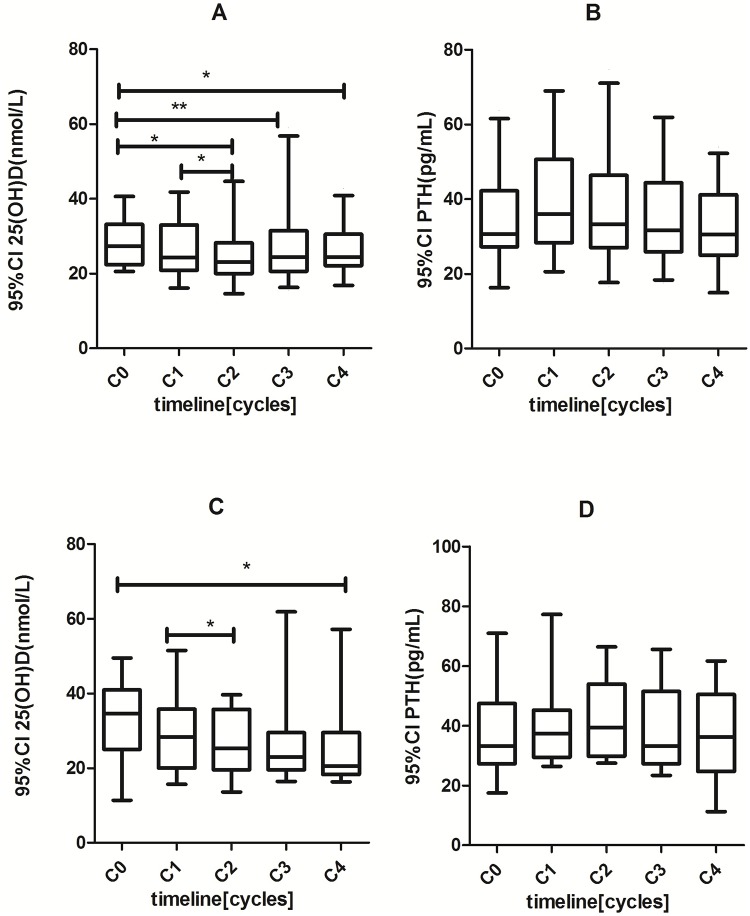
Changes of serum 25(OH)D and PTH levels under different cycles of chemotherapy in pre-menopausal (A and B) and post-menopausal breast cancers (C and D).(*) p<0.05; (**) p<0.01.